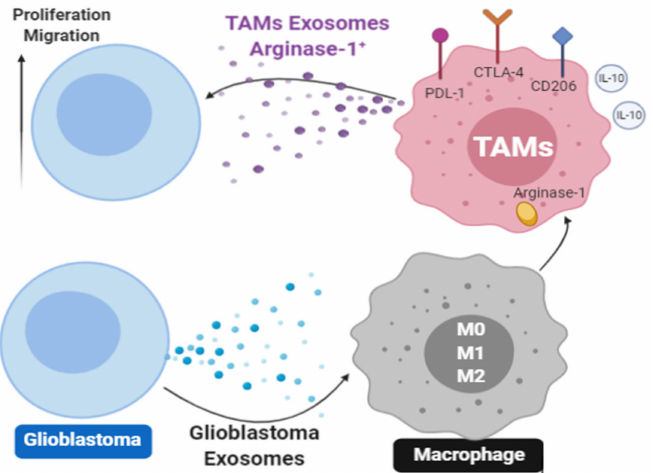
Figure 2. Exosomes produced by glioblastoma cells are taken up by non-malignant macrophages present in the TME and reprogram them by driving their differentiation into tumor associated macrophages (TAMs). Expression levels of inhibitory ligands on the TAM surface, production of arginase 1 and IL-10 by TAMs and secretion of TAM-derived exosomes decorated with arginase 1 and carrying IL-10 are upregulated. TAM-derived arginase-1+ exosomes inhibit anti-tumor immune cells in the TME and drive glioblastoma proliferation. The figure was prepared by Dr. Azambuja based on the published data in reference